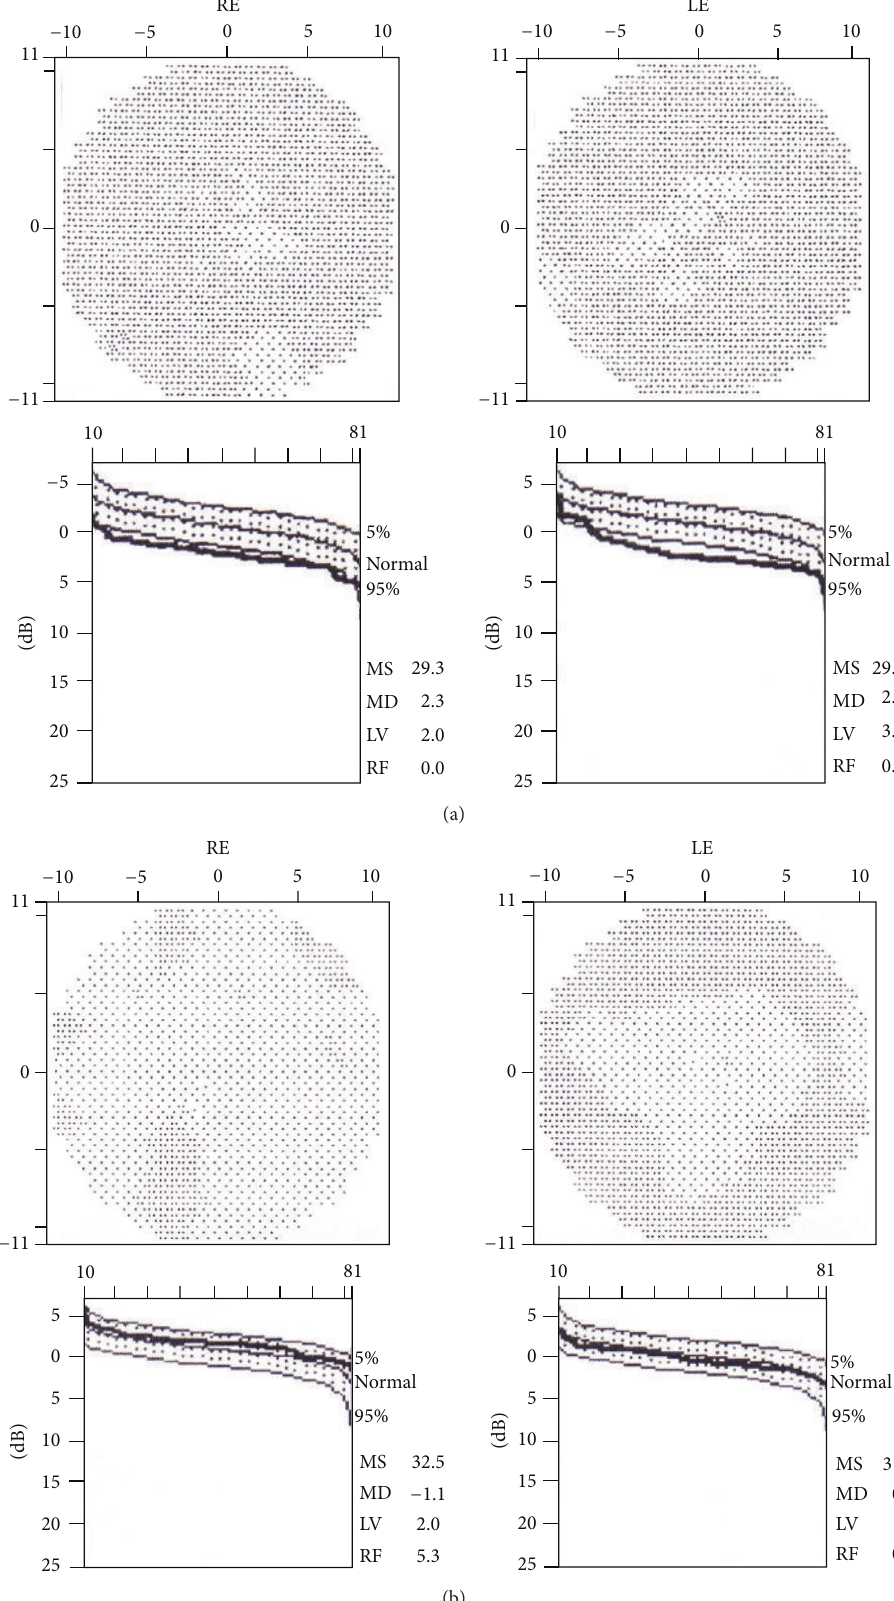
Figure 1: Perimetry 10-2 octopus and retinal sensitivity curve (below) performed before (a) and 34 months after (b) hydroxychloroquine dose deduction. LE: left eye. RE: right